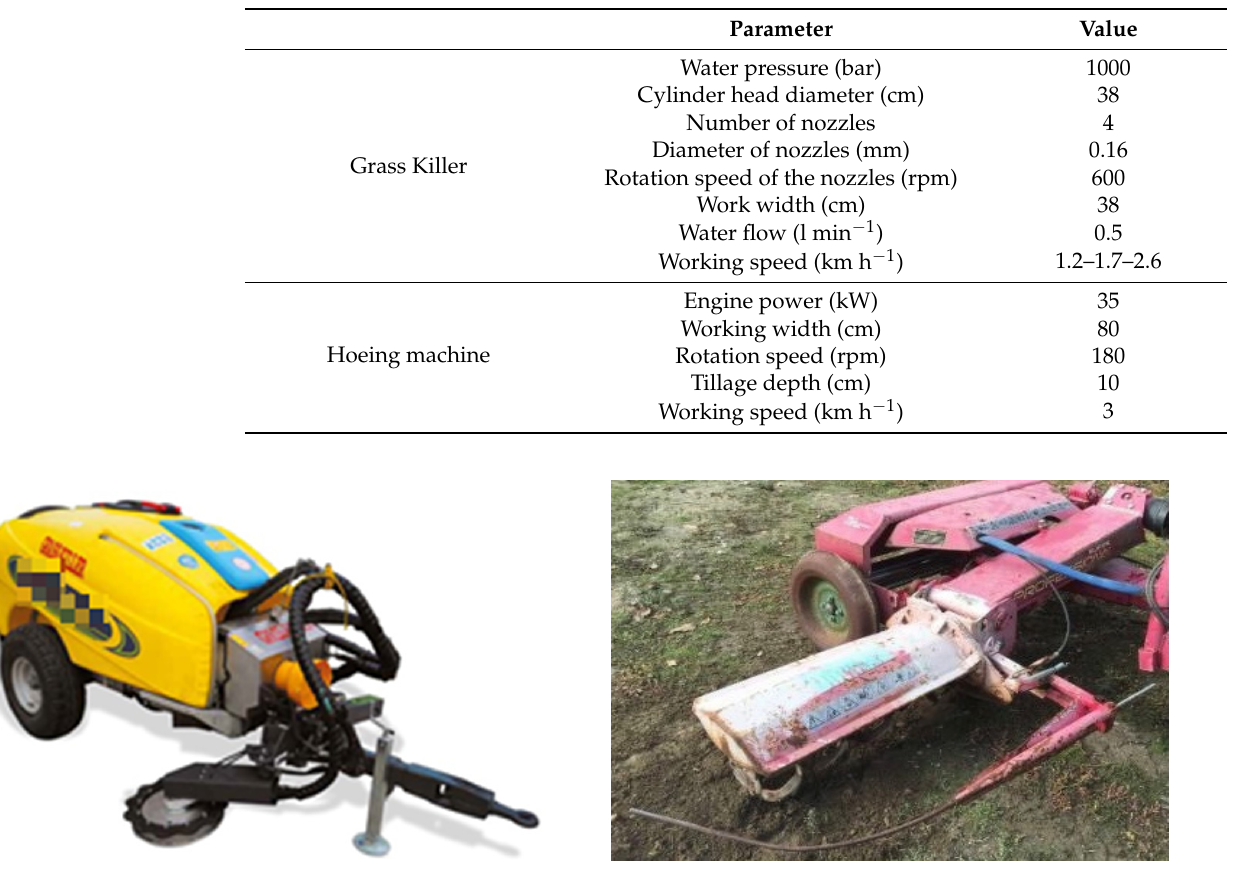
Figure 2. Grass Killer machine ( left ) and hoeing machine ( right ).